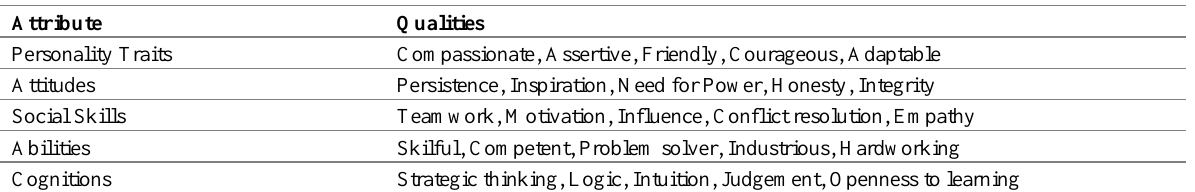
Table 1: Attributes of Effective